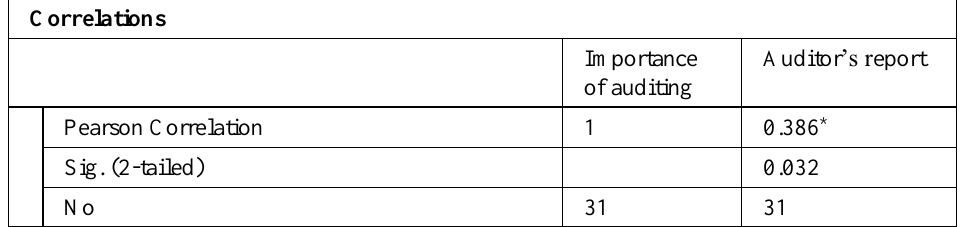
Table 8. The relationship between the importance of the auditing and the auditor’s report [Table and calculations made by authors]